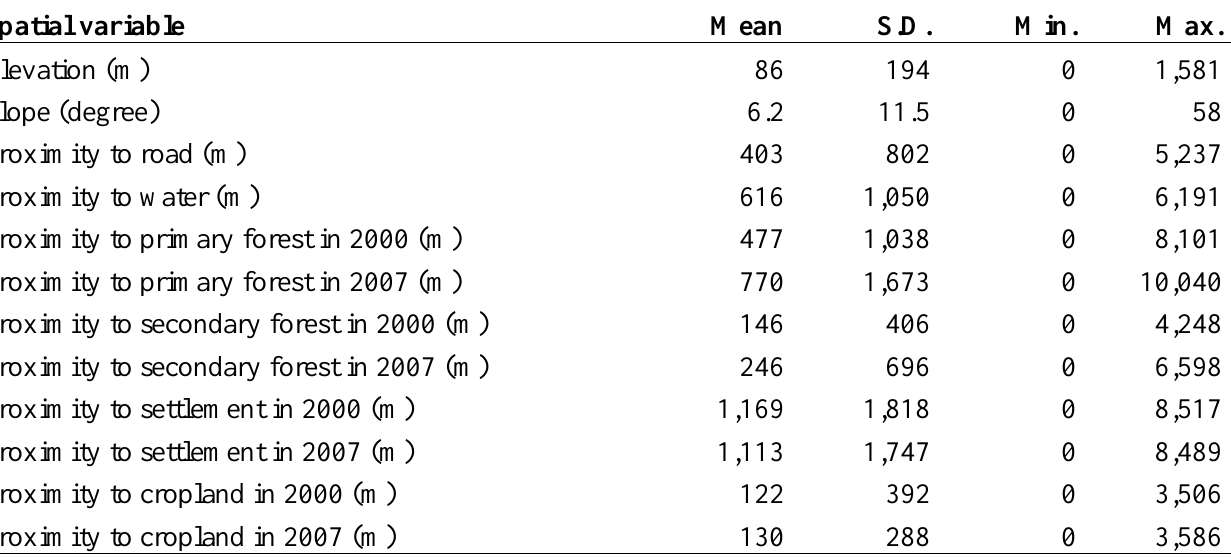
Table 1. Statistical summary of spatial